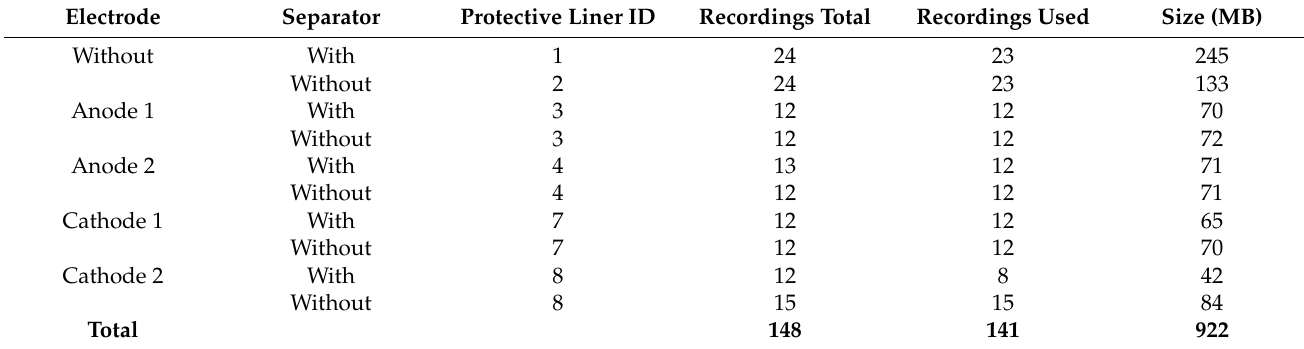
Table 1. Experimental design for acoustic measurement process